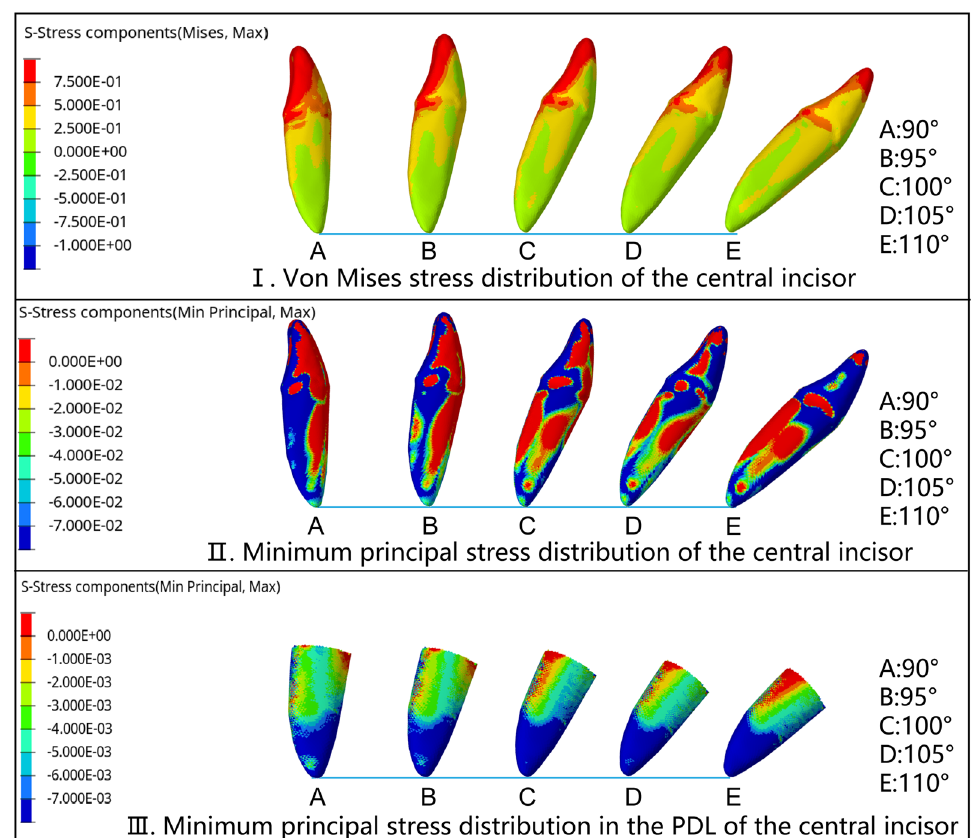
Fig. 5 Stress distribution of central incisors with different IMPA values during the intrusion by 0.2 mm. The sequence is A (90°), B (95°), C (100°), D (105°), and E (110°). I . von Mises stress distribution of the central incisor: The crown stress was mainly concentrated in the lingual fossa and incisal ridge, and the root stress was concentrated in the lingual surface and the proximal cervical area. II . The minimum principal stress distribution of the central incisor: The compressive stress of the crown was concentrated in the lingual fossa and the incisal ridge. The compressive stress on the root was concentrated in the lingual surface and root apex when the initial IMPA was 90° and 95°. With the increase in IMPA, the root compressive stress area changed to the labial surface. When the IMPA was 110°, the compressive stress was concentrated in all areas of the root labial surfaces, from the apex to the root cervix. III . The minimum principal stress distribution in the PDL of the central incisor: The compressive stress was mainly concentrated in the apex. With the increase in IMPA, the compressive stress concentration area expanded to the labial middle 1/3 and cervical 1/3 of the